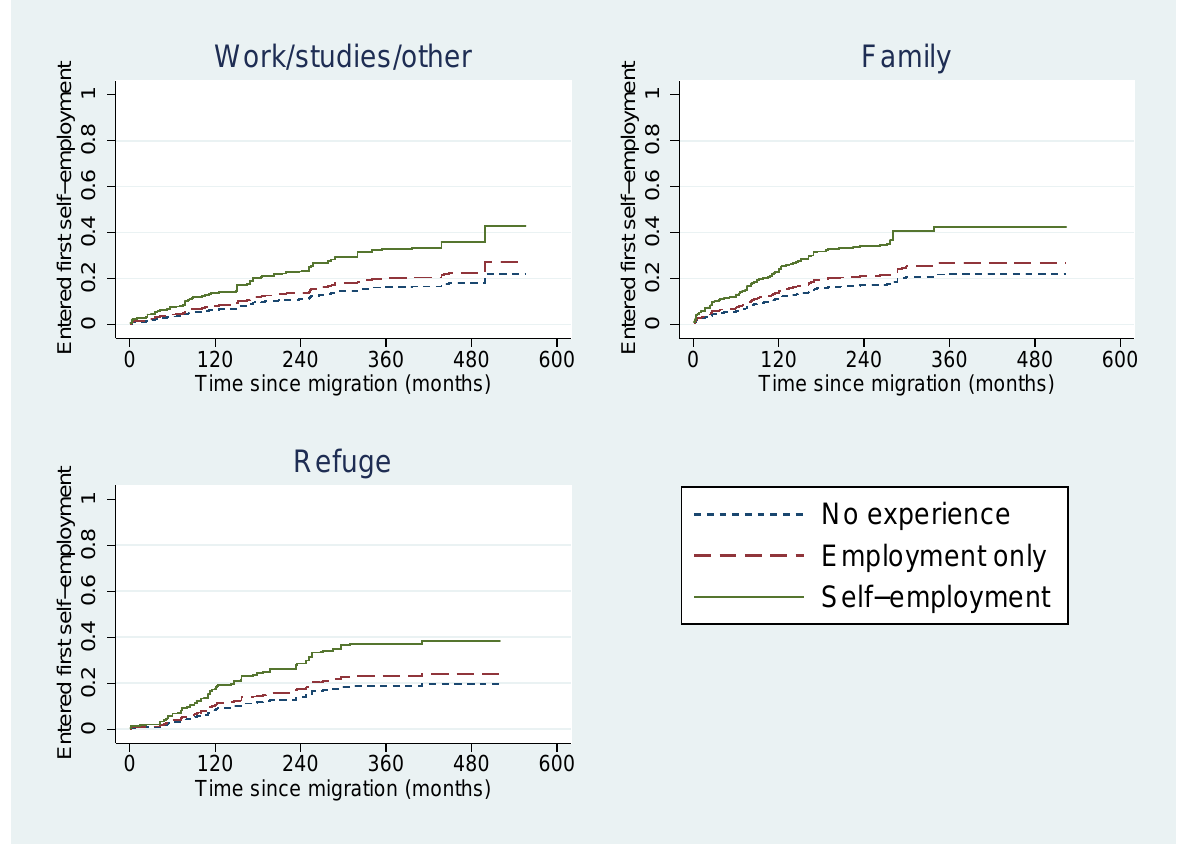
Figure 4: Cumulative entry into first self-employment by experience before immigration. Reversed survival curves are based on the last model in Figure 3 and Table